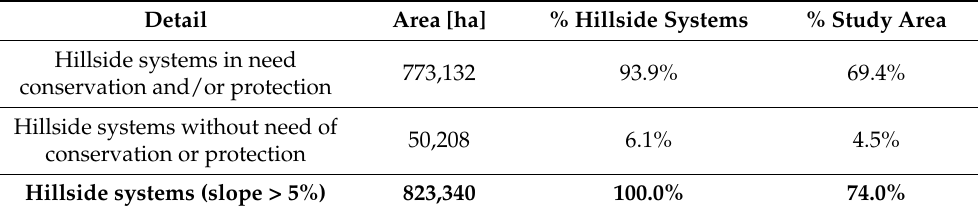
Table 5. Description of criteria for the integrated analysis and their extension in the study area.